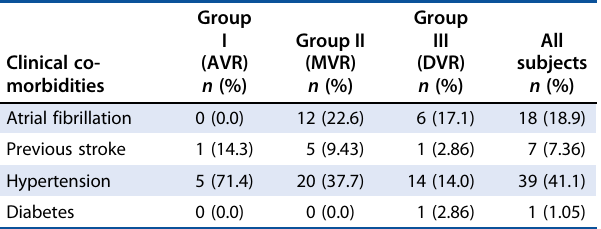
Table 2: Clinical co-morbidities recorded in medical records of the study subjects